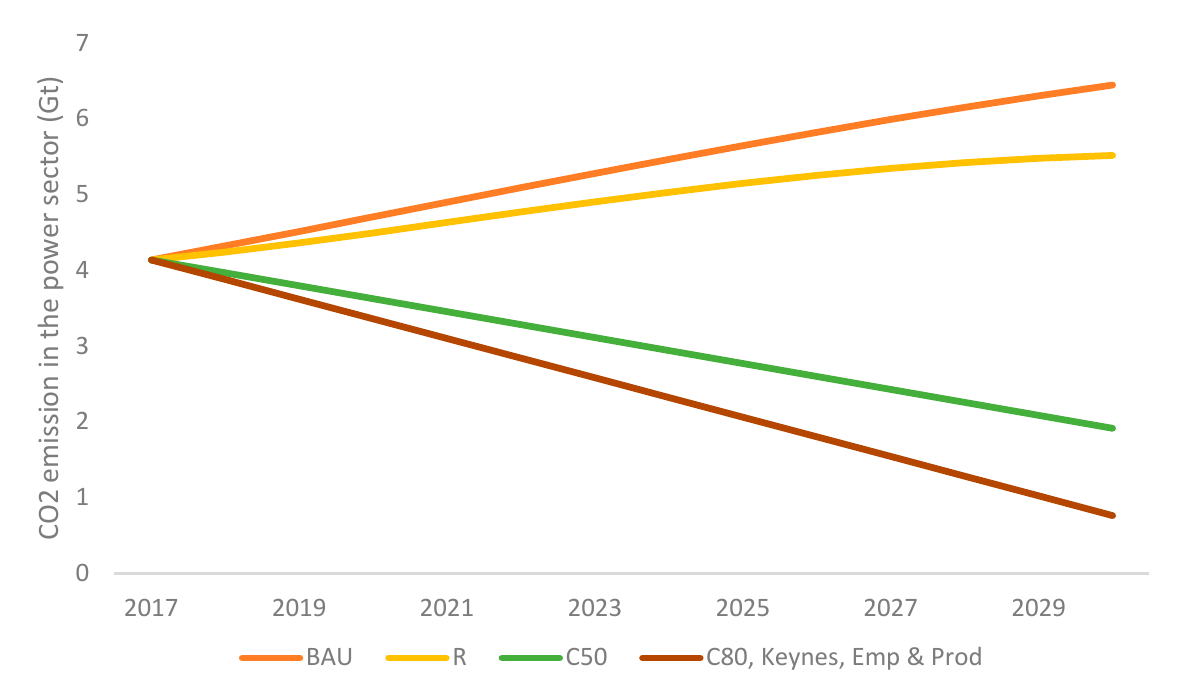
Figure 4. CO 2 emissions in the power sector from 2017 to 2030. Table 3. Macroeconomic Impacts in China (change from 2030 BAU in real billion RMB and